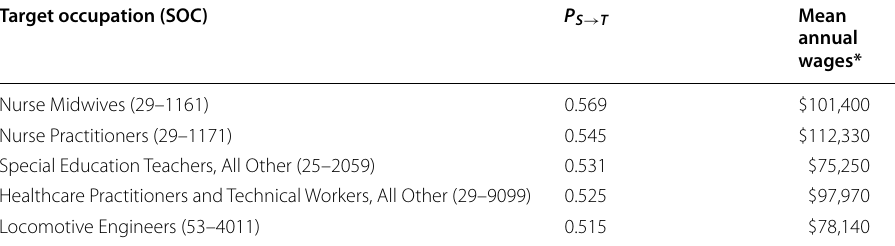
* Taken from the 2018 OEWS by MSA (U.S. Bureau of Labor Statistics 2018)